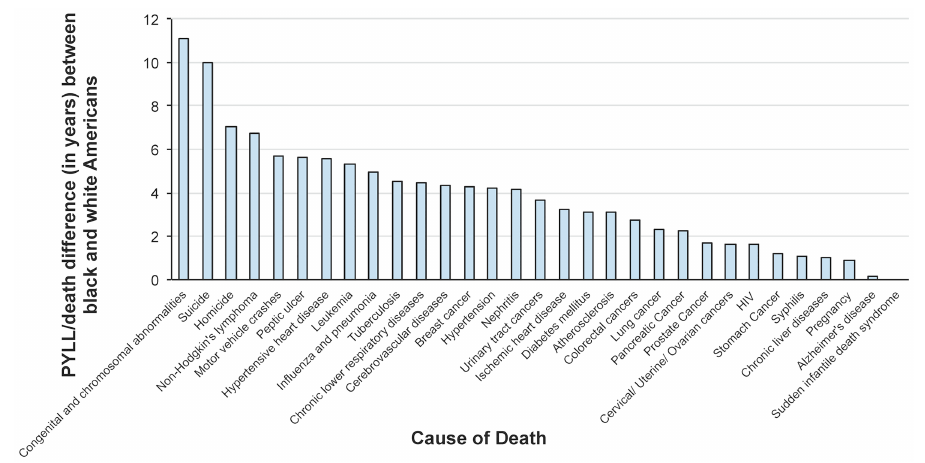
Fig 2. Disparity in PYLL per death attributed to each of 31 specific causesof death between black and white Americans in